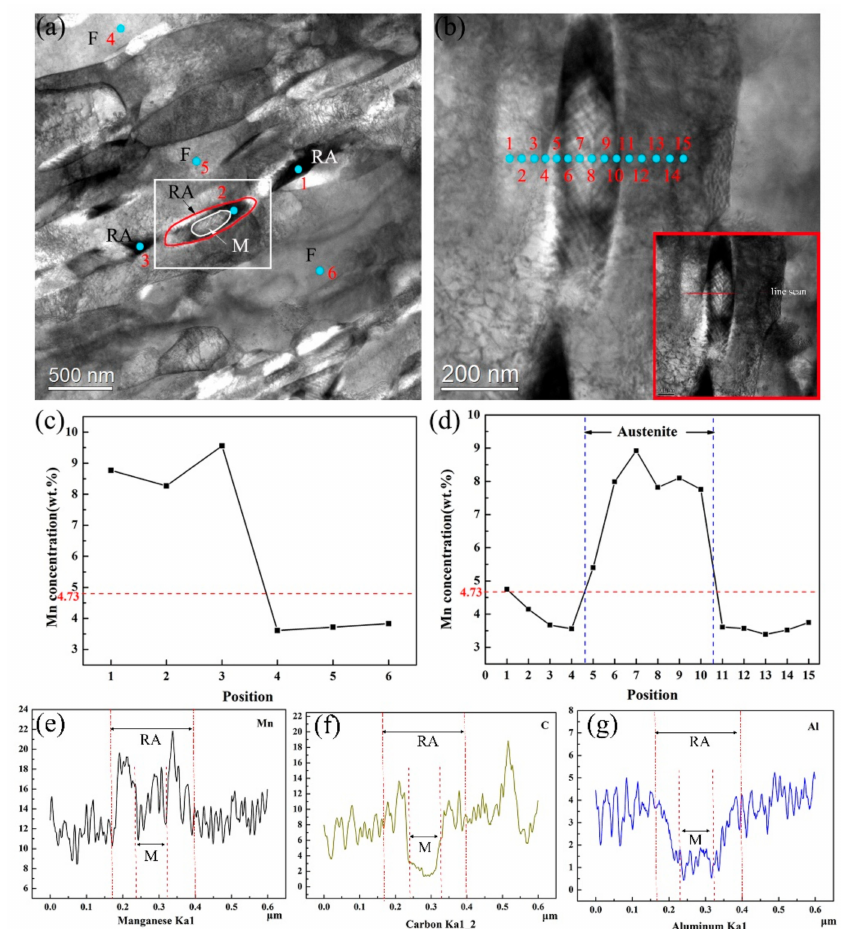
Figure 11. TEM micrograph and EDS analysis showing evidence of Mn partitioned among austenite, ferrite, and martensite: ( a ) TEM micrograph of the 650 ◦ C sample; ( b ) TEM micrograph of the area denoted by white square in ( a ); ( c ) manganese partitioned in austenite and ferrite of the 650 ◦ C sample in ( a ); ( d ) manganese partitioned among austenite, ferrite, and martensite of the 650 ◦ C sample in ( b ); ( e – g ) Line scan of the area denoted by red square in ( b ) for Mn, C, and Al, respectively. F, ferrite; RA, retained austenite; M, martensite; Red coordinates 4.73, the nominal chemical composition of